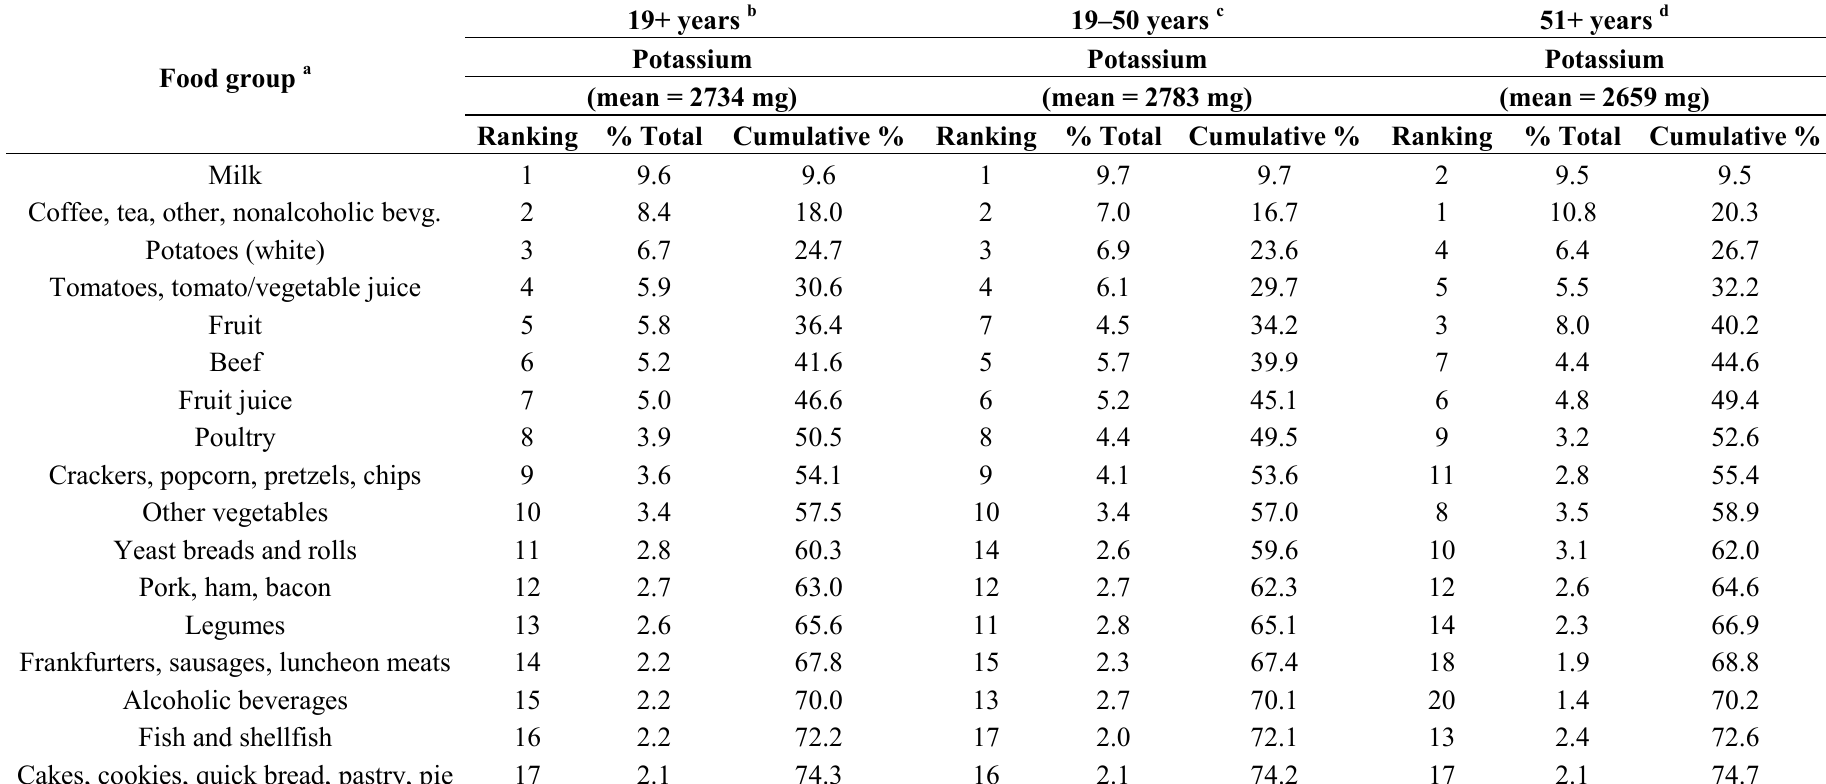
Table 10. Food sources of potassium among US adults (from NHANES